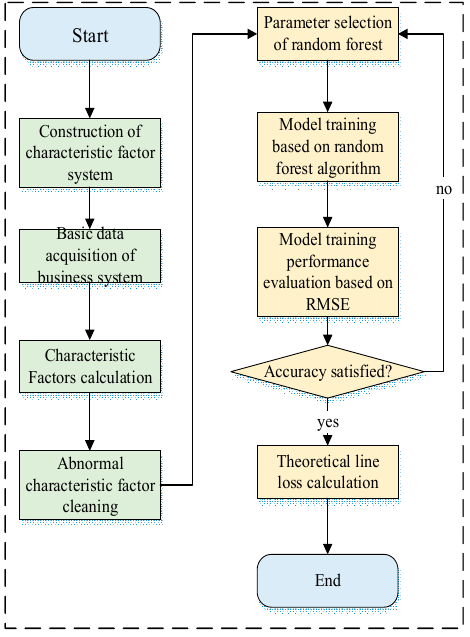
Figure 5. The schematic diagram of the topological structure of the RF algorithm.